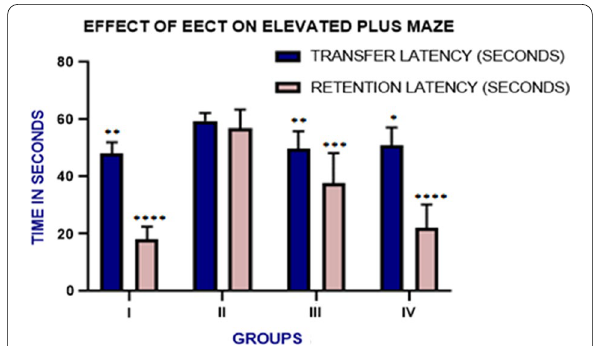
Fig. 4 Effect of EECT on elevated plus maze